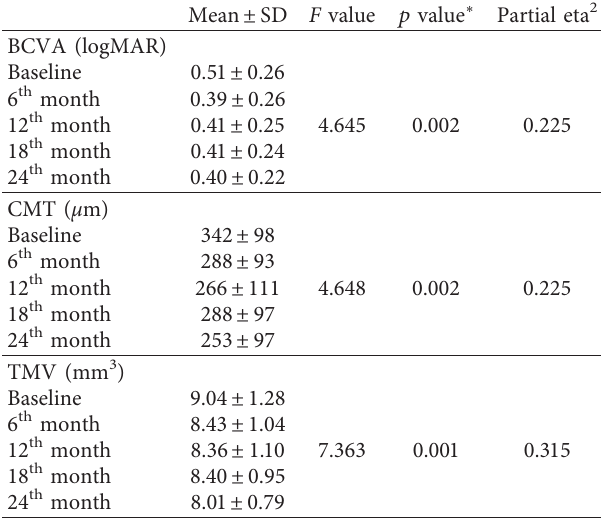
Table 3: Effect of treatment on BCVA, CMT, and TMV values in the nonvitrectomized group ( n �